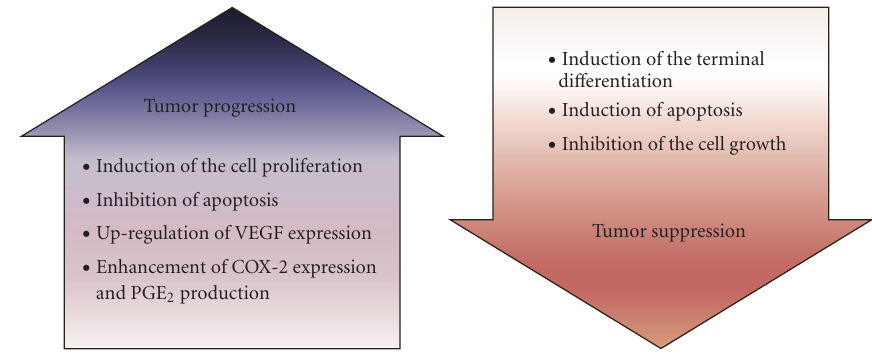
Figure 2: Does PPAR δ progress or suppress tumor growth?